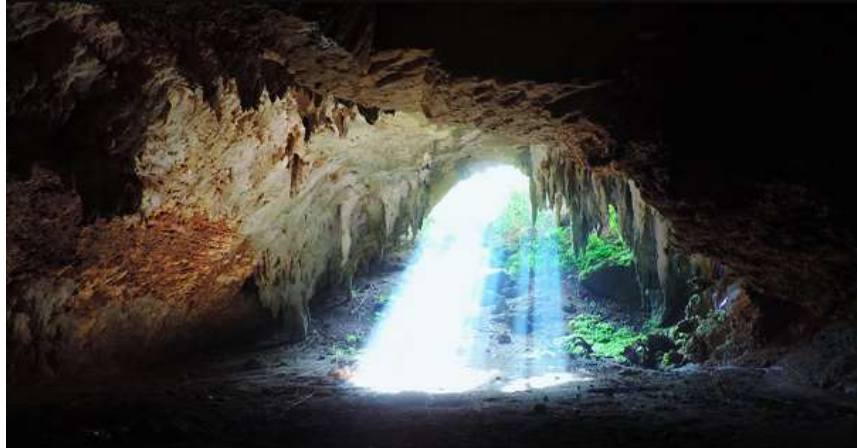
Figure 3. Lanang